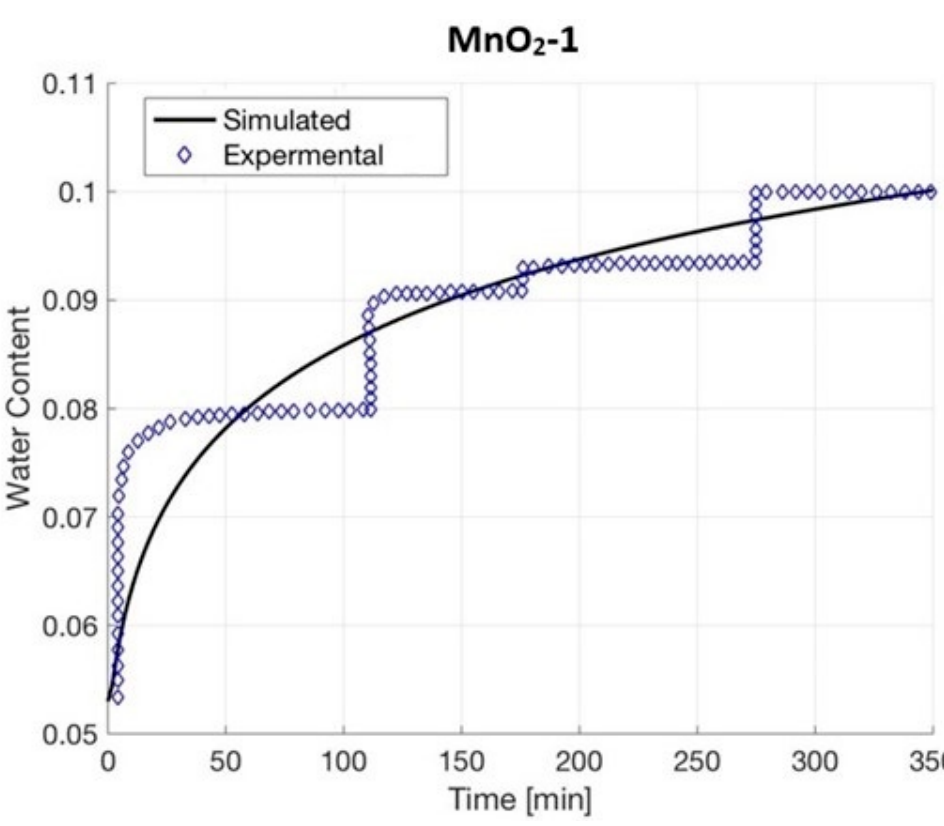
Figure 13. Comparison of HAW model of MnO 2 -1 (a)